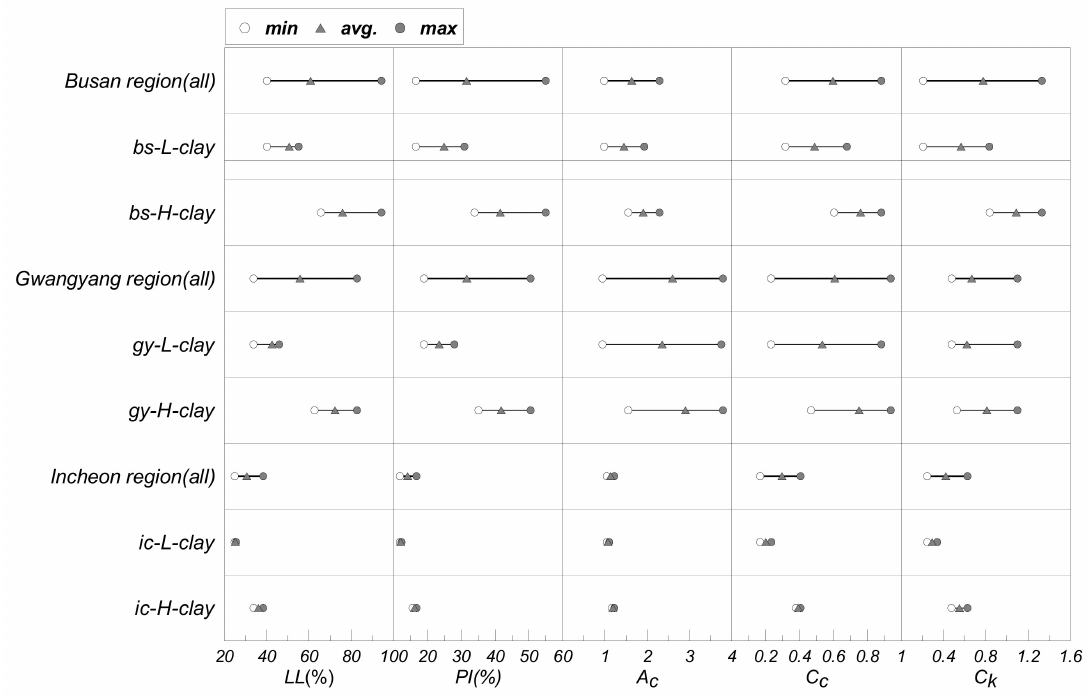
Figure 8. Engineering properties for the classified marine soft soil by liquid